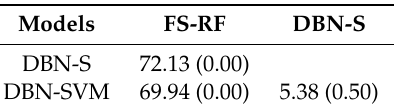
Table 14. The chi-square and p values based on independent test set between different models. FS-RF: random forest with feature selection method. DBN-S: deep belief network (DBN) with softmax classifier. DBN-SVM: the fused model of DBN and support vector